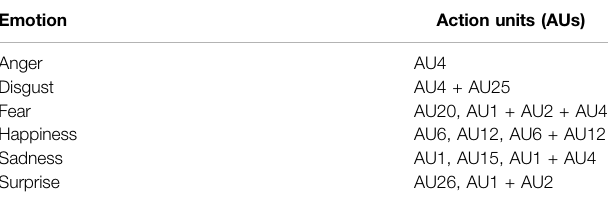
TABLE 1 | AUs or combination of AUs used to detect the spontaneous mimicry of thefacialexpressionsofthe sixbasicemotions (based onEkman et al.(2002)) Emotion Action units (AUs)